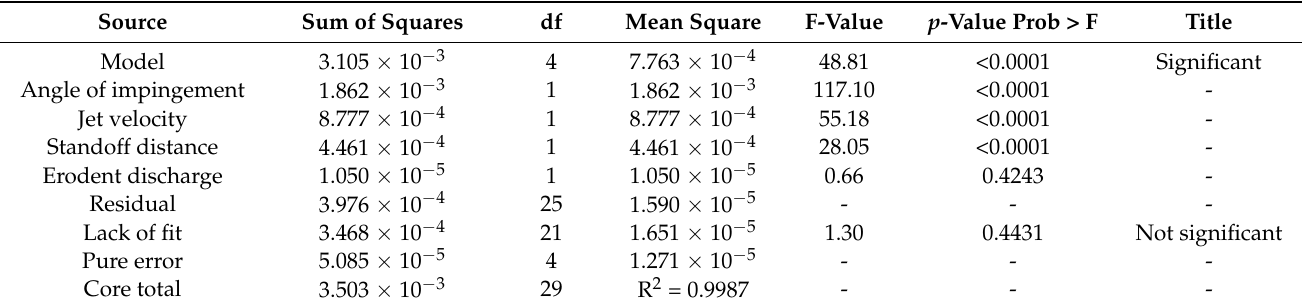
Table 5. ANOVA results for the uncoated stainless steel.